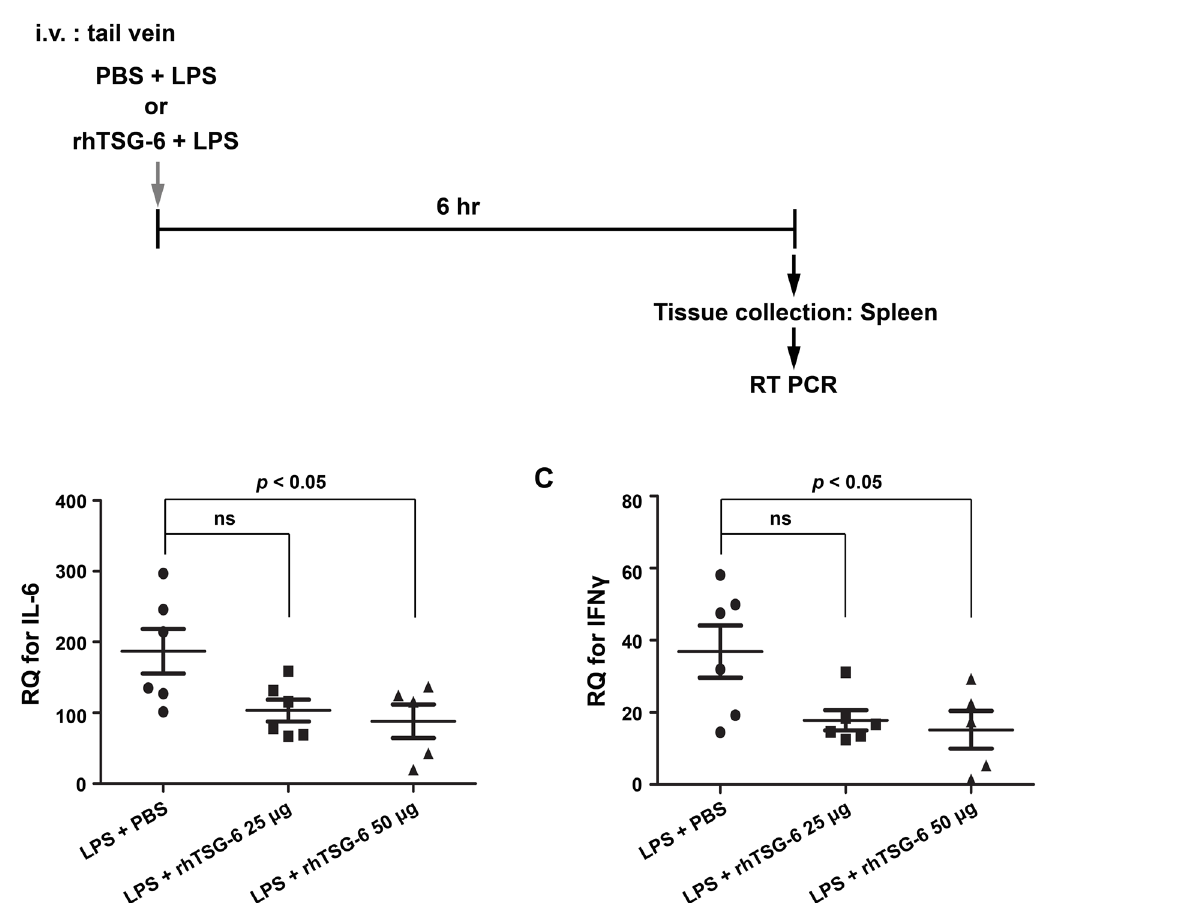
Fig 6. Purified rhTSG-6 suppressed LPS-induced inflammation in mice. (A) Schematic for the experiment. (B, C) rhTSG-6 suppressed LPS-induced levels of mRNA for IL-6 and IFN γ in spleen. Statistical calculation was performed by a one-way ANOVA followed by the Tukey multiple comparison post hoc test. Data are presented as mean ± S.E.M. Symbol: RQ, relative